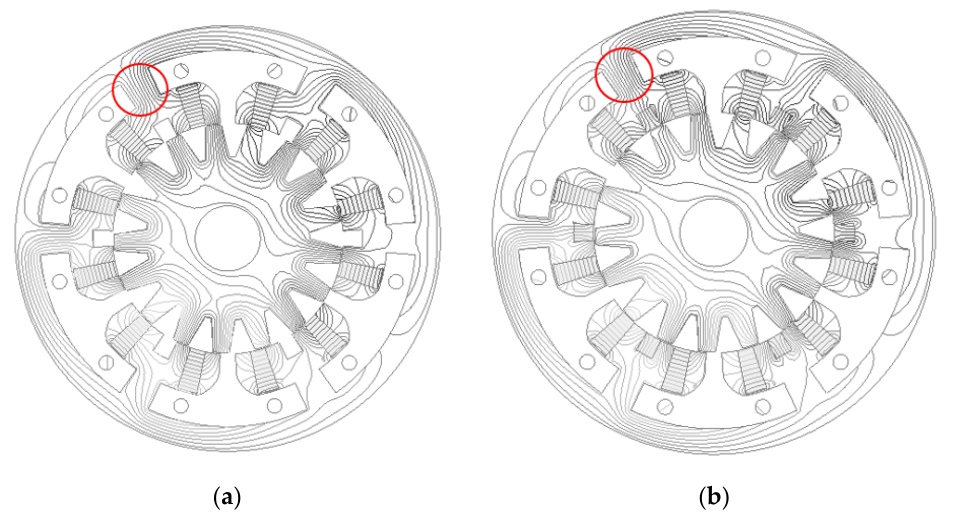
Figure 4. No ‐ load magnetic flux distributions of two FSPM machines: ( a ) conventional 6/17 FSPM Figure 4. No-load magnetic flux distributions of two FSPM machines: ( a ) conventional 6 / 17 FSPM machine; ( b ) proposed 6/17 FSPM machine. machine; ( b ) proposed 6 / 17 FSPM